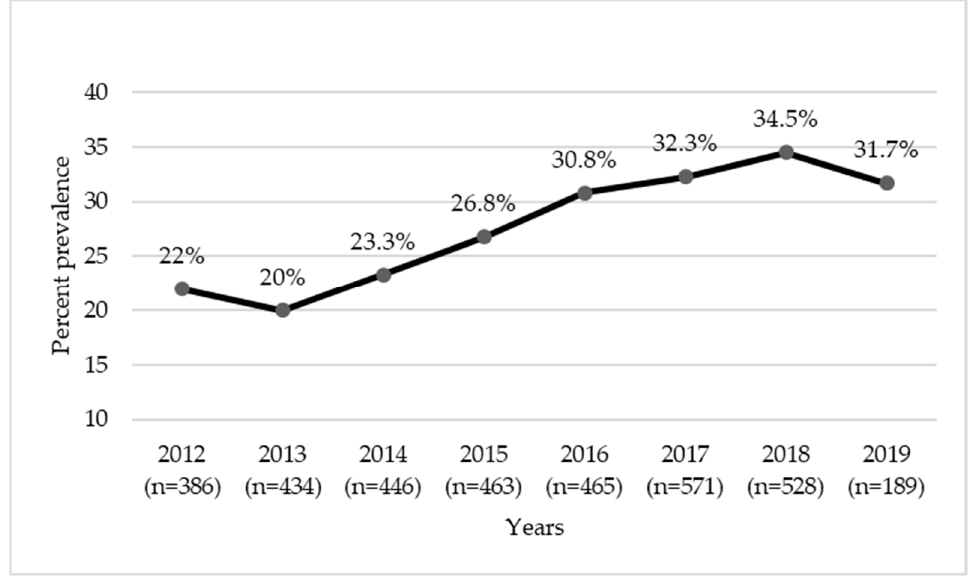
Figure 2. Overall methicillin-resistant Staphylococcus (MRS) prevalence by year (2012–2019). Total numbers of isolates (both susceptible and resistant) for each year are shown in parenthesis on the x -axis.